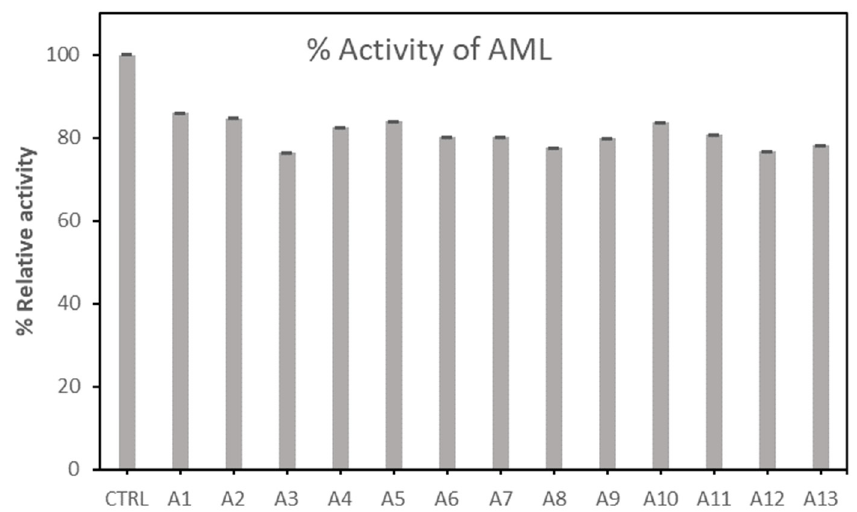
Figure 1. Relative activity of Amano lipase (AML) after immobilization on activated carbon samples from A1 to A13. Data are presented with 95% confidence intervals (error bars).